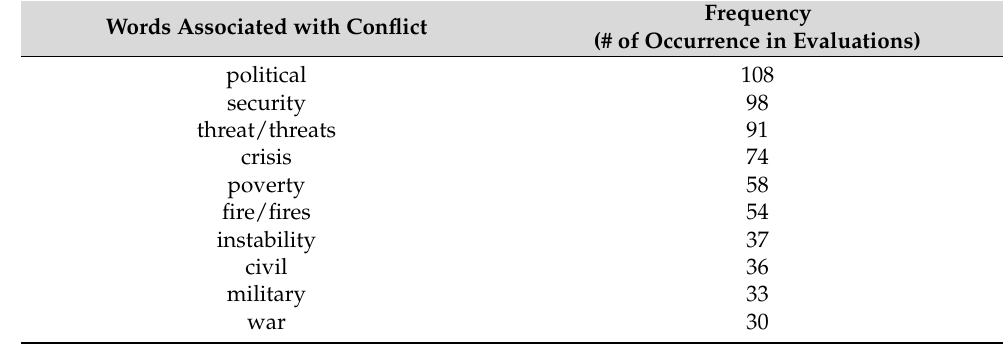
Table 4. Words frequently associated with conflict in biodiversity project evaluations resulting from NLP